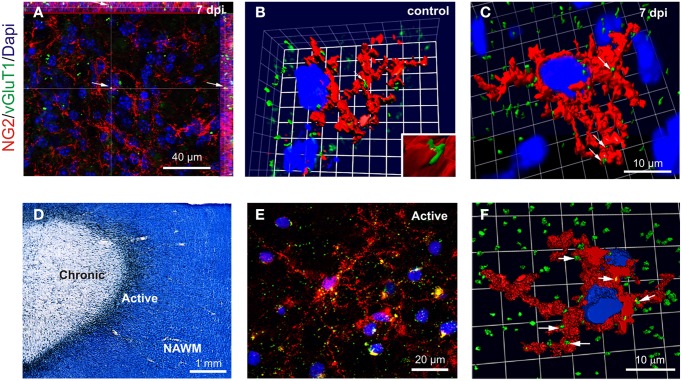
VGluT1+ a xon-OPC contacts in LPC-demyelinated and MS lesions. (A) Immunohistochemistry showing NG2 (red) and VGluT1 (green) labeling in a LPC-induced lesion at 7 dpi. Arrow indicates a VGluT1 puncta. (B,C) 3D reconstruction of NG2 (red) and VGluT1 (green) labeling in control (B) and LPC-induced lesions at 7 dpi (C). Contacts are indicated by arrows. (D) MS brain section stained with Luxol fast blue/MHCII (black), illustrating a typical chronic active lesion in the subcortical white matter. The different areas of the lesion were classified as active, chronic silent and normal appearing white matter (NAWM). Active borders of chronic active lesions were filled with MHCII+ macrophages/microglia, while chronic silent cores were devoid of labeling. (E) Immunohistochemistry showing NG2 (red) and VGluT1 (green) staining in the active border of a chronic active lesion. (F) 3D reconstruction of a NG2 cell (red) with VGluT1 puncta (green, arrows) in the active border of a lesion. Nuclei were stained with Dapi (blue).